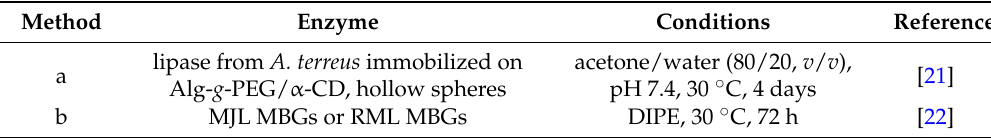
Table 1. Enzymes and conditions used on the kinetic enzymatic hydrolysis of rac -Ketoprofen vinyl ester by methods a and